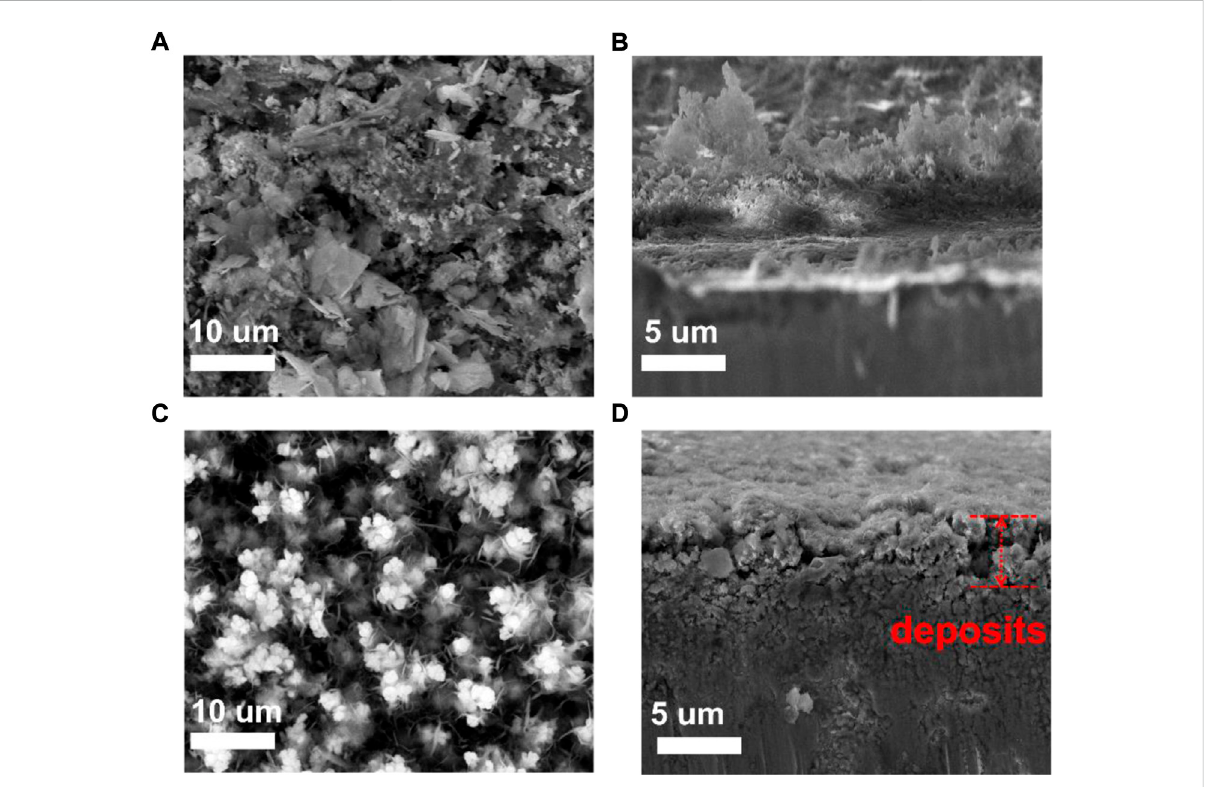
FIGURE 3 SEM images and the cross-sectional images of bare Zn and 3D-Cu-coated electrodes after deposition at 3 mAh cm − 2 . (A,B) Bare Zn electrode. (C,D) 3D-Cu-coated